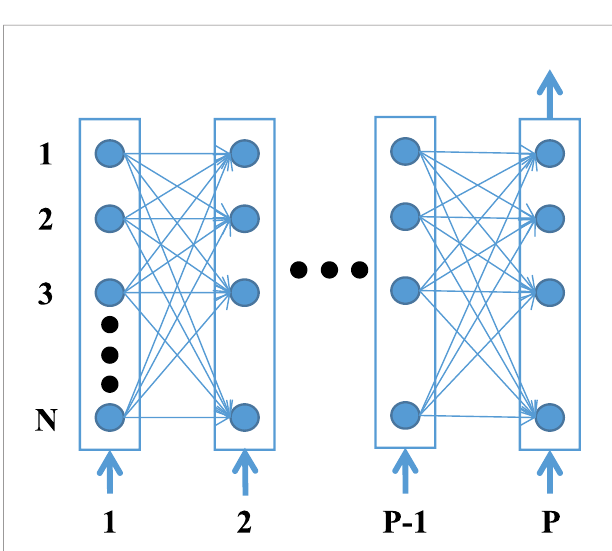
FIGURE 2 | The schematic structure of a RNN unfolded in time. Each node corresponds to a gene and a connection between two nodes de fi nes their interaction.